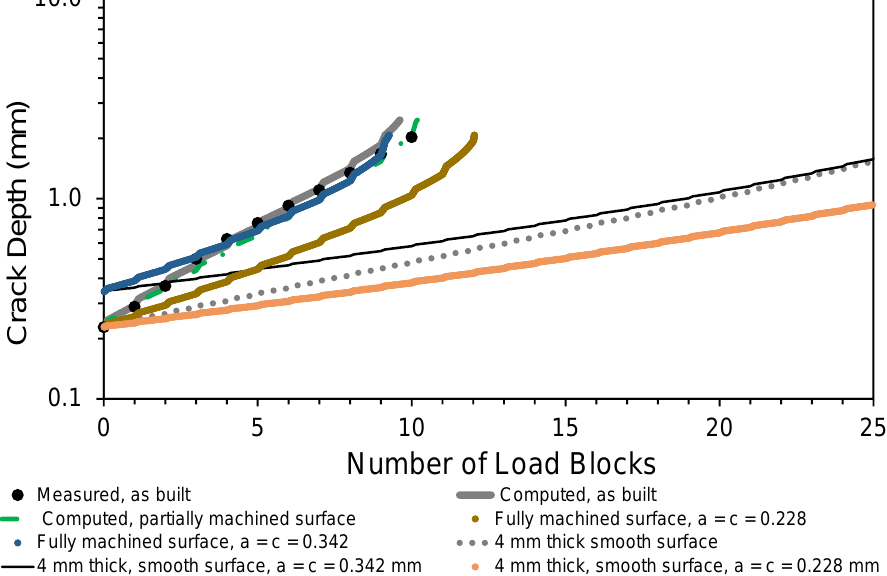
Figure 7. The measured and computed crack depth curves shown in Figure 5, together with the corresponding curve obtained for the partially machined surface and a specimen with a fully machined surface with a semi-circular surface-breaking crack.